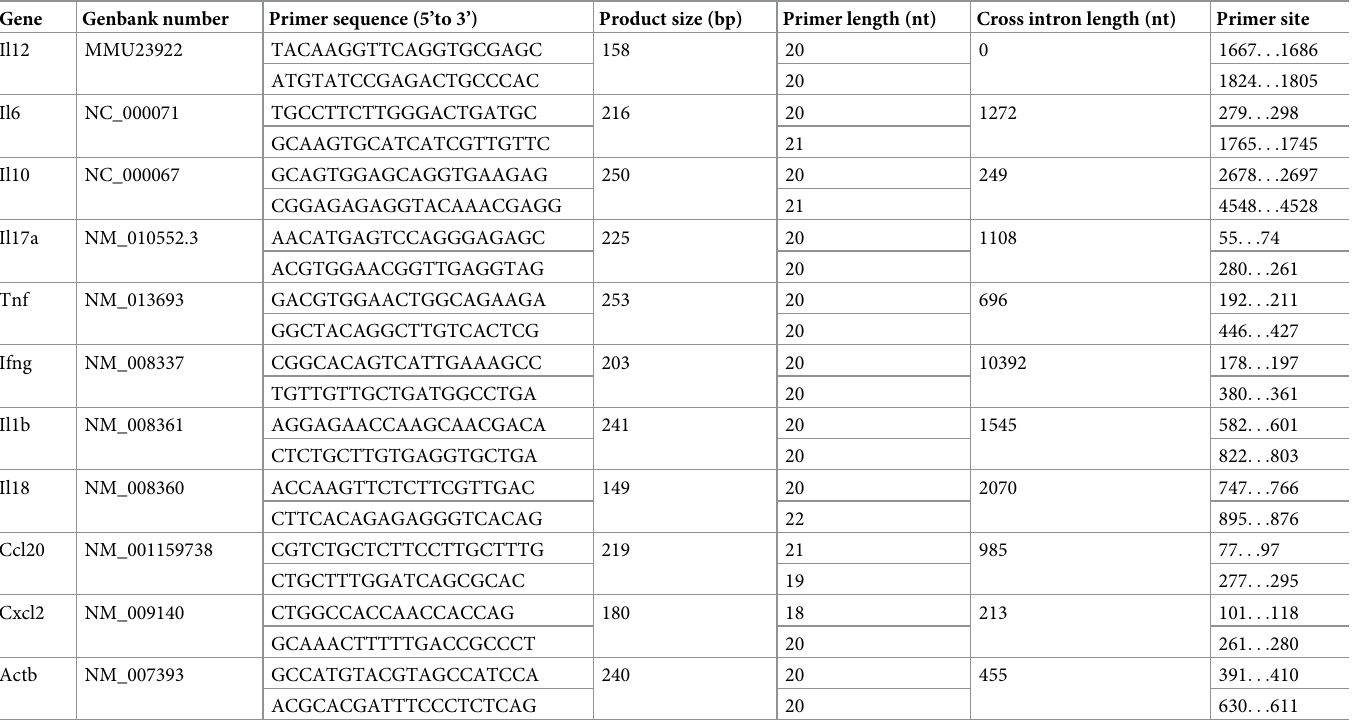
Table 1. Primers used for qRT-PCR analysis of cytokines. Gene Genbank